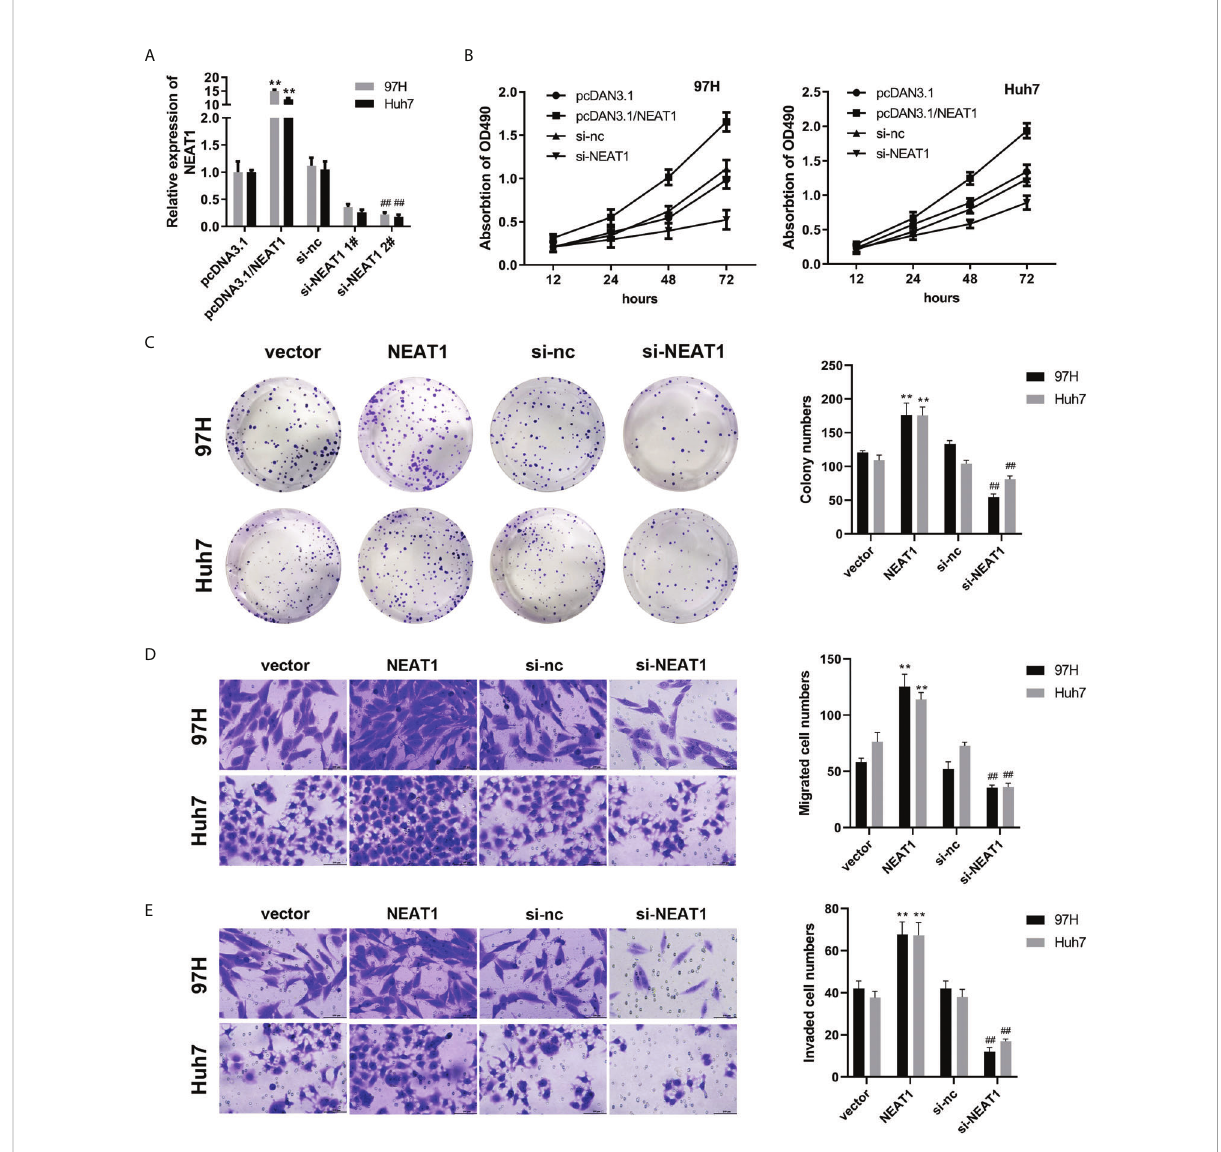
FIGURE 1 Knockdown of NEAT1 can inhibit the viability, proliferation, migration, and invasion of hepatocellular carcinoma cells. (A) qPCR was used to detect the overexpression or interference ef fi ciency of NEAT1. (B, C) The MTT and colony formation assay were used to detect cell viability and proliferation. (D, E) A Transwell assay was performed to evaluate the migration and invasion of HCC cells. ** indicates P < 0.05 compared with pcDNA3.1 or vector; ## indicates P < 0.05 compared with